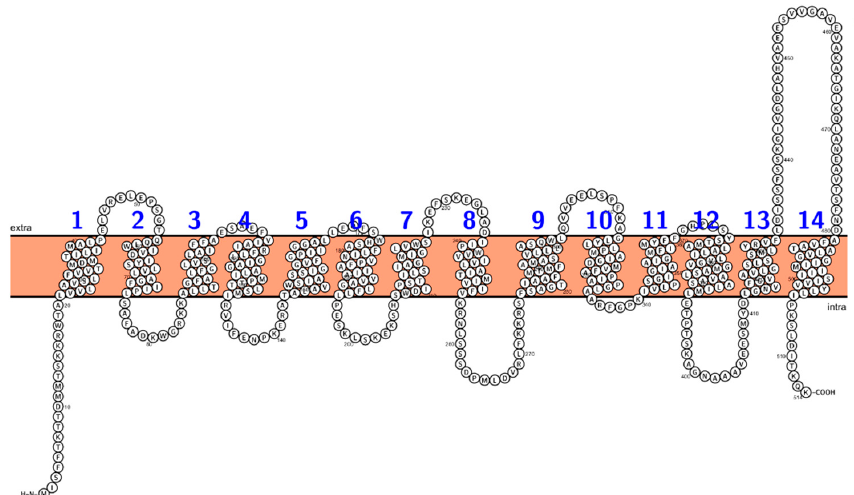
Figure 1. Topology of QacA. The transporters of the MFS have 12 to 14 transmembrane helices. Shown here is the two-dimensional structure of the multidrug efflux pump QacA, a well-studied MFS transporter from S. aureus [51].